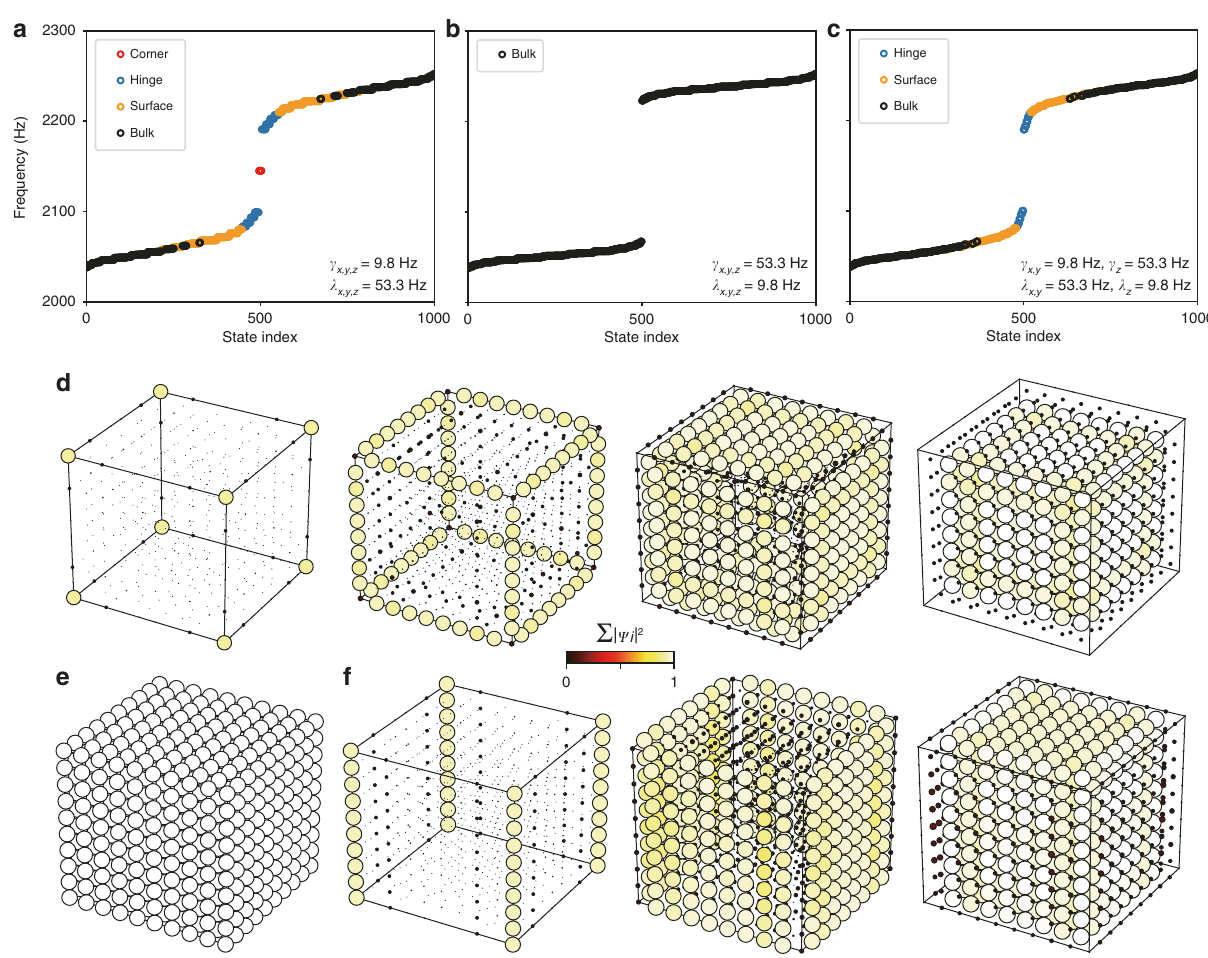
Fig. 2 Calculations on fi nite lattices in topological and trivial phases. a – c Calculated eigenvalues of 5 × 5 × 5 lattices with different coupling con fi gurations. d – f Sum of probabilities for different types of states in a – c , respectively. In a , there are four types of states (bulk, surface, hinge and corner), which are plotted in d . In b , all the states are bulk states ( e ). In c , there are three types of states (bulk, surface and hinge), which are plotted in f